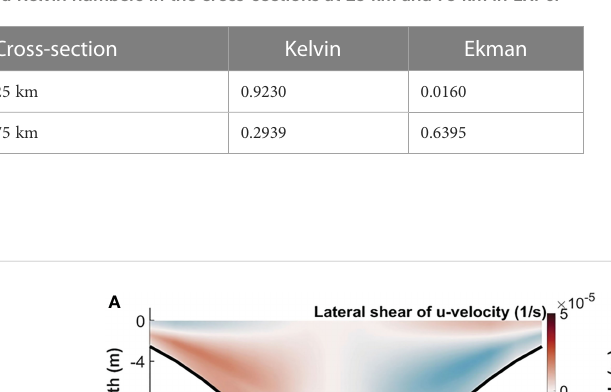
) (A, C, E, G) and lateral velocities (B, D, F, H) along the cross section at 25 km (A – D) and y